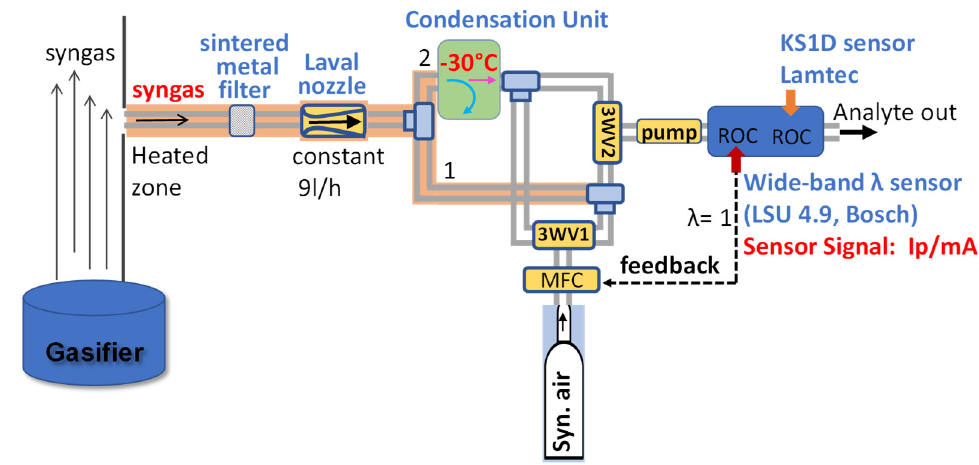
Figure 4. Schematic illustration of the tar monitoring setup connected with the syngas output tube of a gasifier. The settings of measurement are indicated in Figure 2.